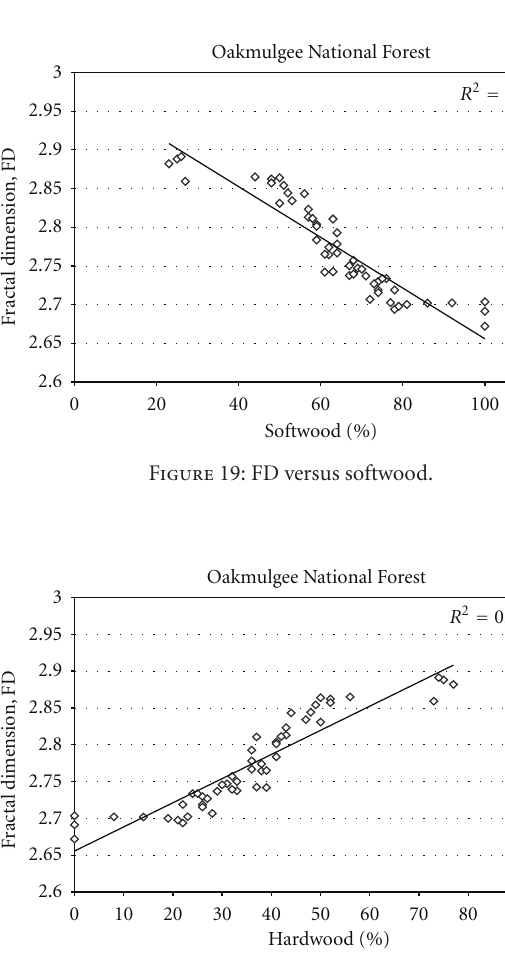
Figure 20: FD versus